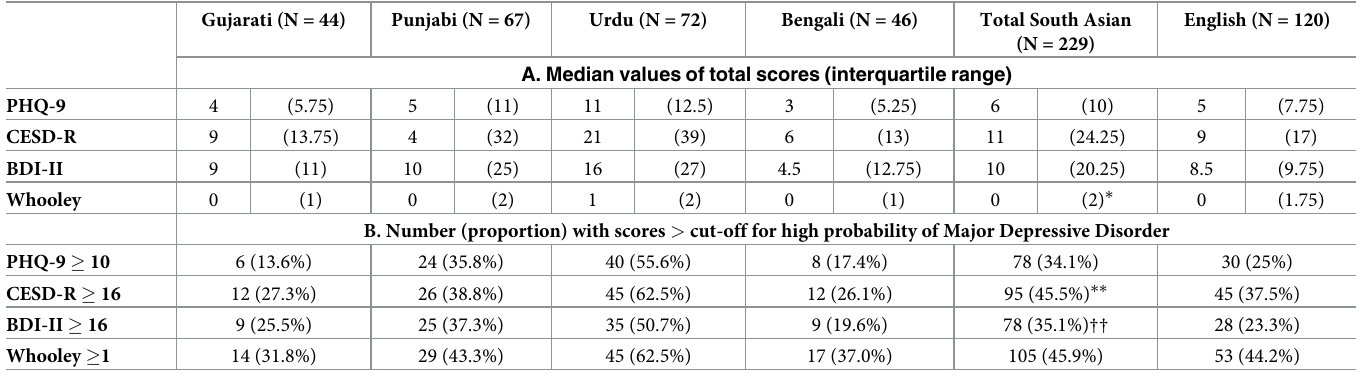
Table 3. Median (interquartile range) scores across depression screening questionnaires and proportion of patients scoring above established screening thresholds.